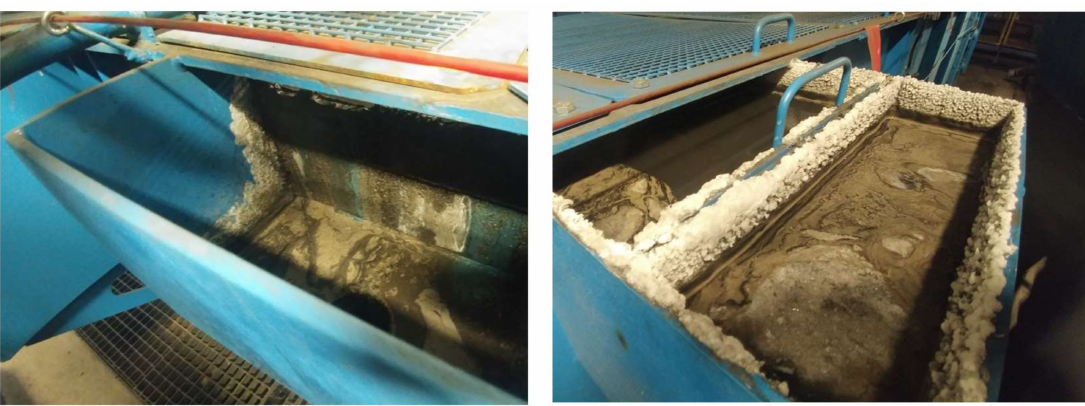
Figure 6. Tribocorrosion traces on the walls of deslagger water trap occurred during operation with high temperature water in the